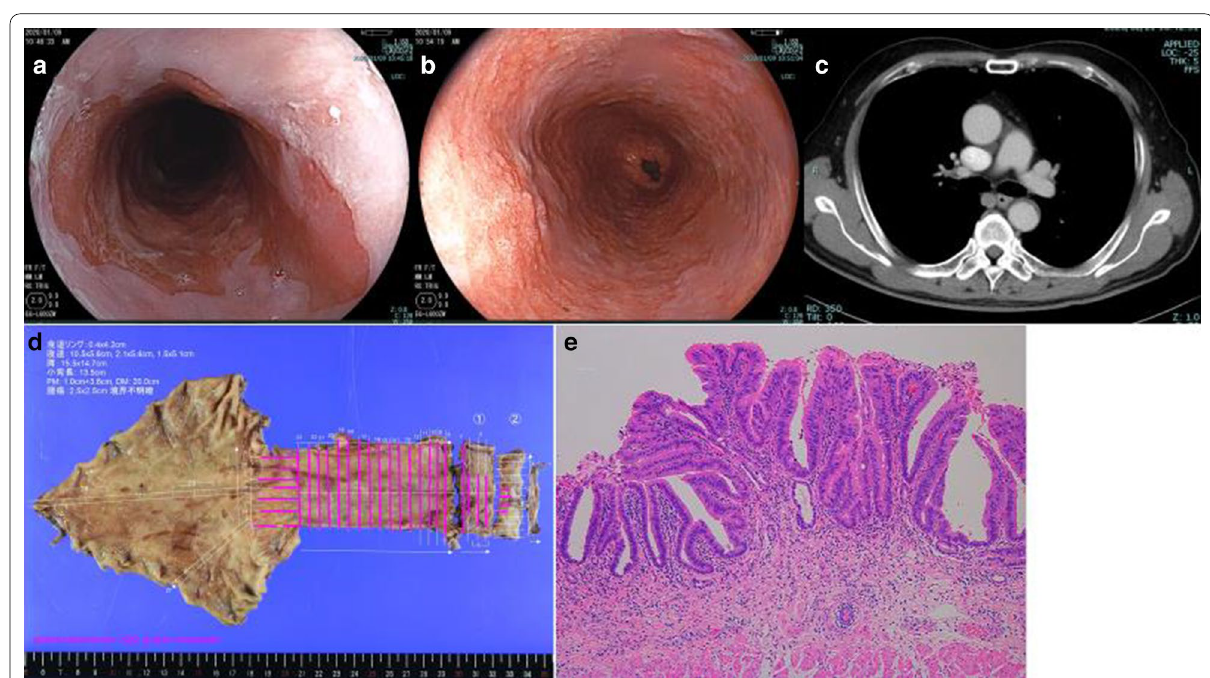
Fig. 3 Endoscopy, computed tomography, and histopathological findings for case 3. a , b Endoscopy revealed a squamocolumnar junction 20 cm from the incisor teeth and a type 0-IIb IIc tumor with indistinct boundaries 30 cm from the incisor teeth. c Computed tomography + detected no enlarged lymph nodes and no other distant metastatic sites. d , e The postoperative pathological diagnosis was of well-differentiated adenocarcinoma (143 56 mm) with no lymph node metastasis (pT1a pN0 pM0 pStage ×